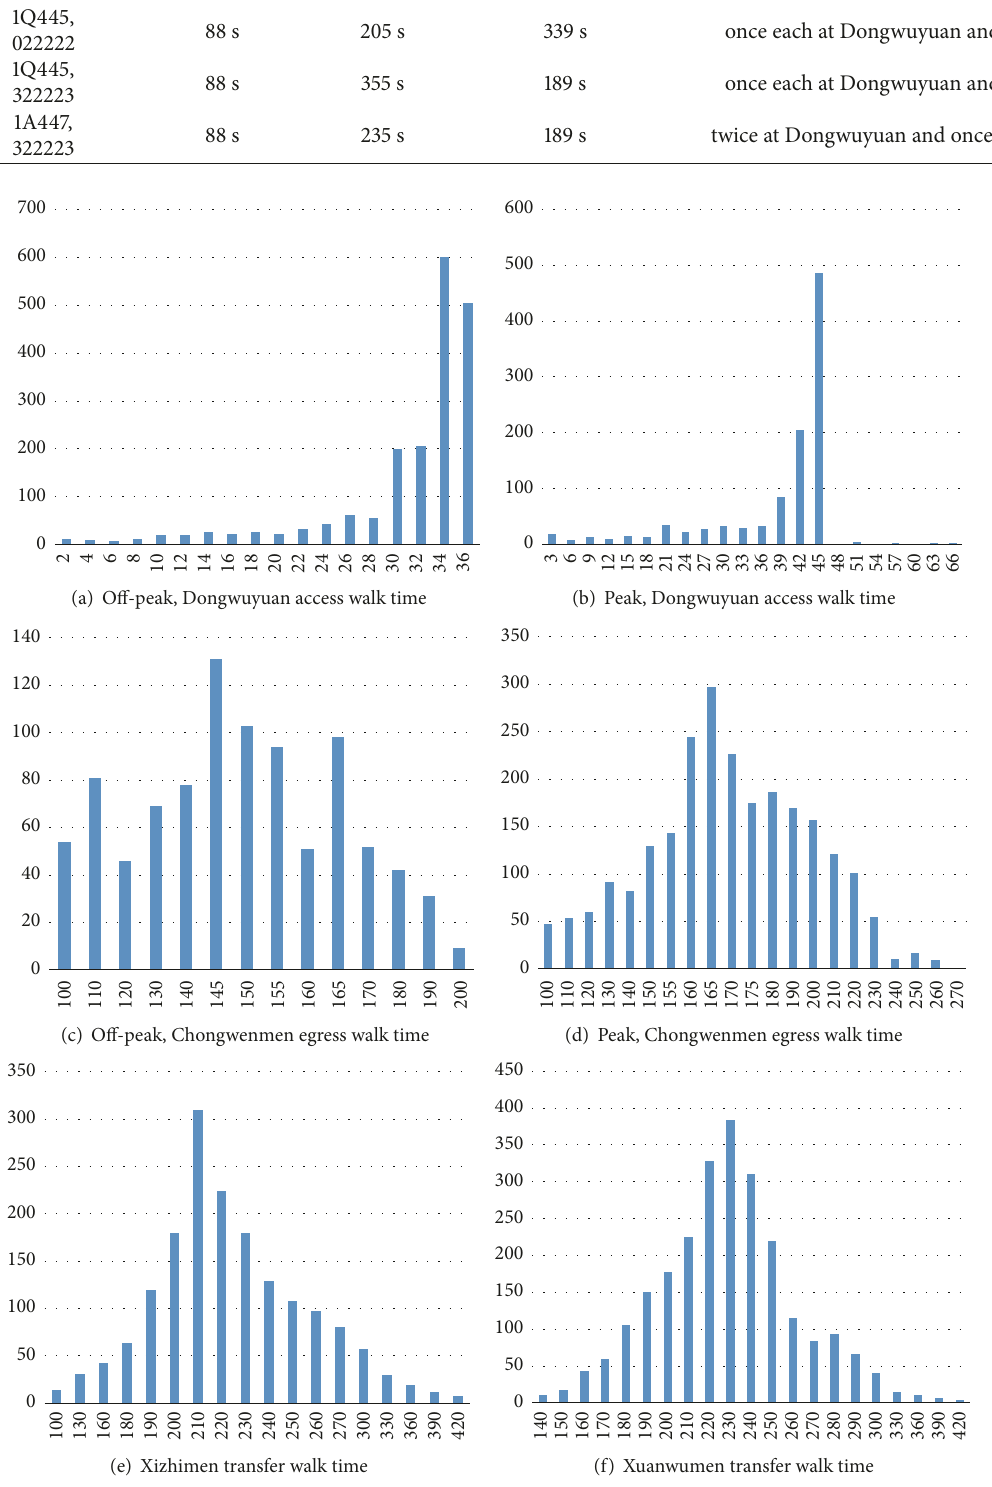
Figure 5: Estimation result of distribution of station-time